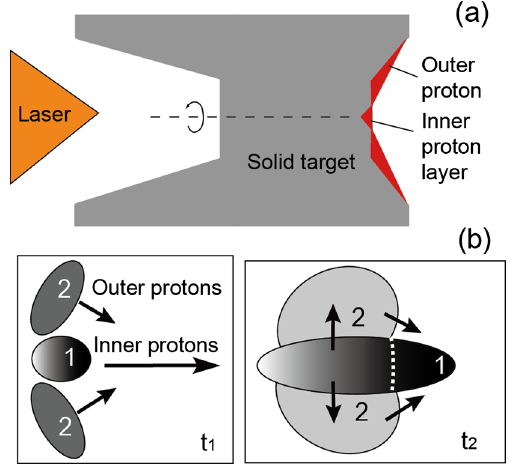
FIG. 1. (a) Sketch of the two-stage acceleration target, show- ing the target-front hollow cylinder with conical inner wall, the main target slab, which has a flat front and dishlike back side, where the tapered center and the two beveled outer proton layers are shown in red, and (b) schematic diagrams of the acceleration